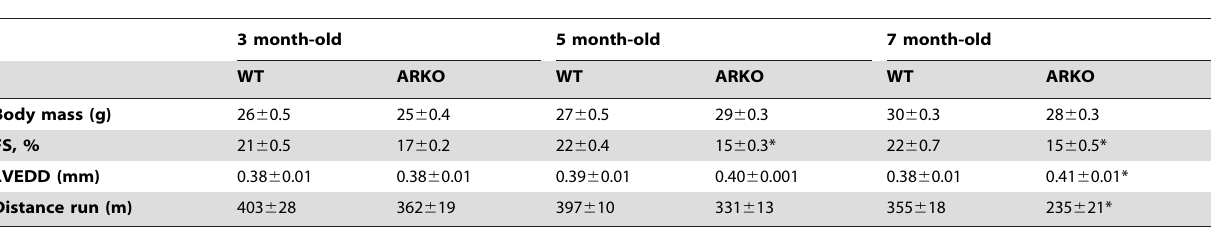
Table 1. a 2A / a 2C ARKO mice physiological